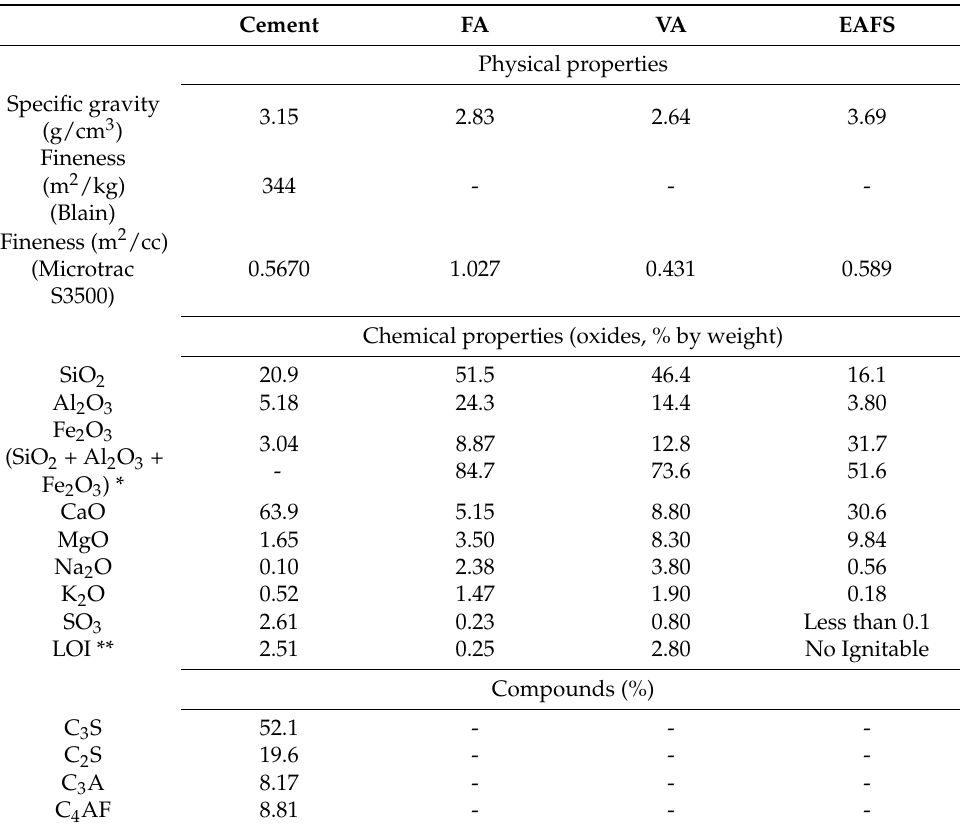
Table 1. Physical properties and chemical composition (oxides, % by weight) of cement, volcanic ash (VA), fly ash (FA), and electric arc furnace slag